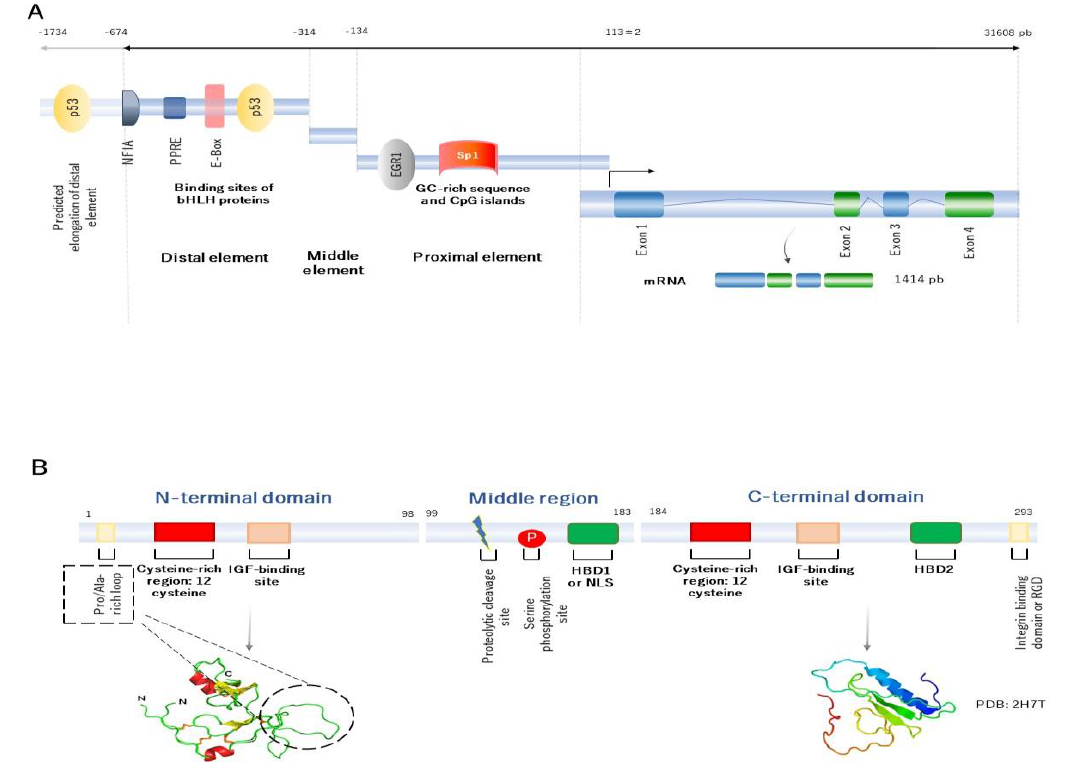
Figure 1. Human representative of IGFBP2 genetic and molecular structure. ( A ) Human representative of genetic structure of IGFBP2 . There are three regulatory elements, ranging from distal, middle to proximal elements. The structure gene contains four exons and three introns. The product is a mature mRNA of 1414 pb. ( B ) Human representative structure of IGFBP2 protein domain for the mature protein of 289 amino acids residues. There are three principal domains. The N-terminal domain, the middle domain or the middle region and the C-terminal domain. The N- (extracted from Galea C. et al. [9]) and C-terminal (PDB: 2H7T for the C-domain of IGFBP2) domain are presented. Both N- and C-terminal domains contain IGF binding sites, which suggests that these domains are highly conserved. However, the middle region has a proteolytic cleavage and phosphorylation sites, which indicates that this domain may be implicated in the regulation of bioavailability of IGF1 and stability of the protein